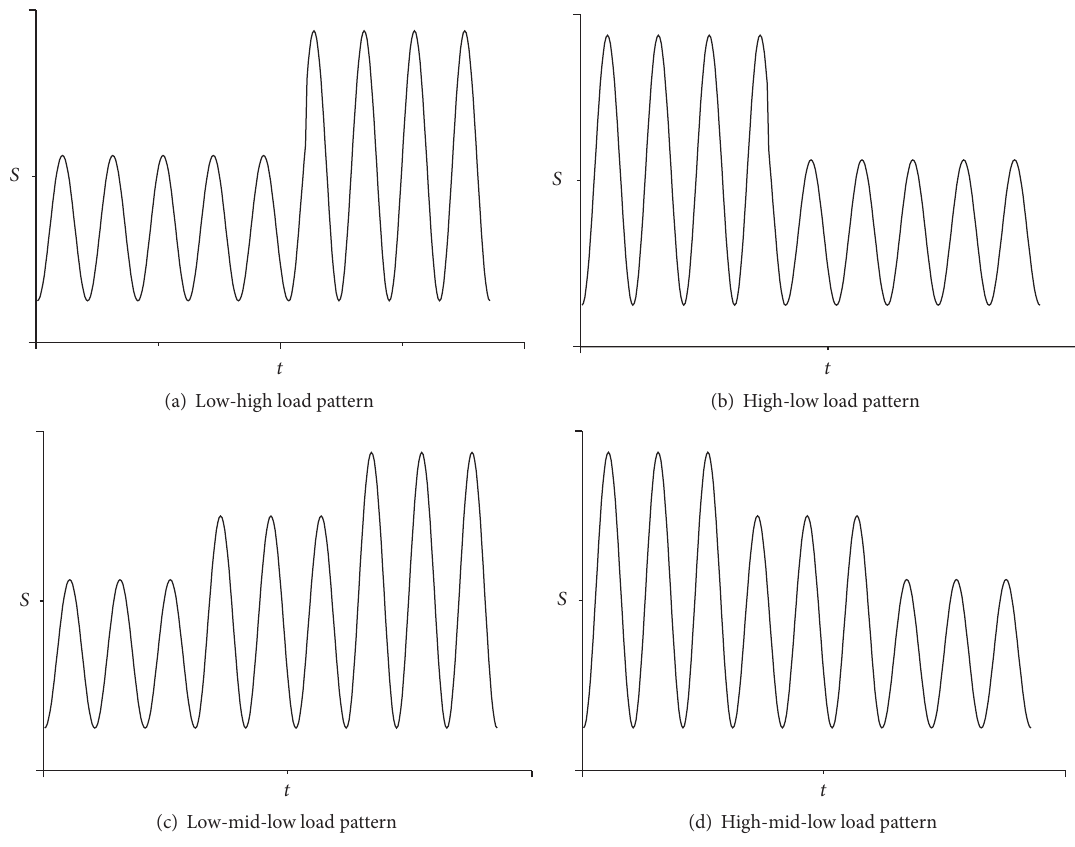
Figure 2: Load patterns of variable amplitude multistage fatigue